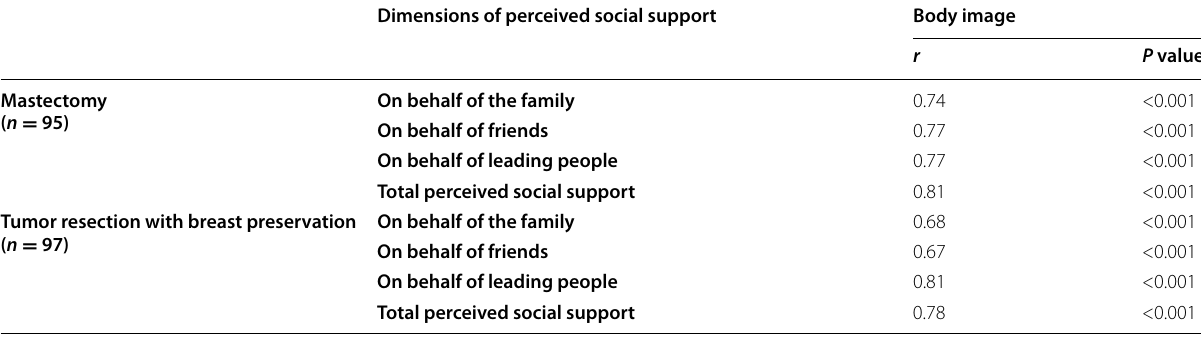
Table 2 Evaluation of the relationship between perceived social support and its dimensions with body image in two groups of mastectomy and tumor resection with breast preservation in women with breast cancer referred to the accelerator ward of Golestan Hospital in Ahvaz in 2018 and 2019